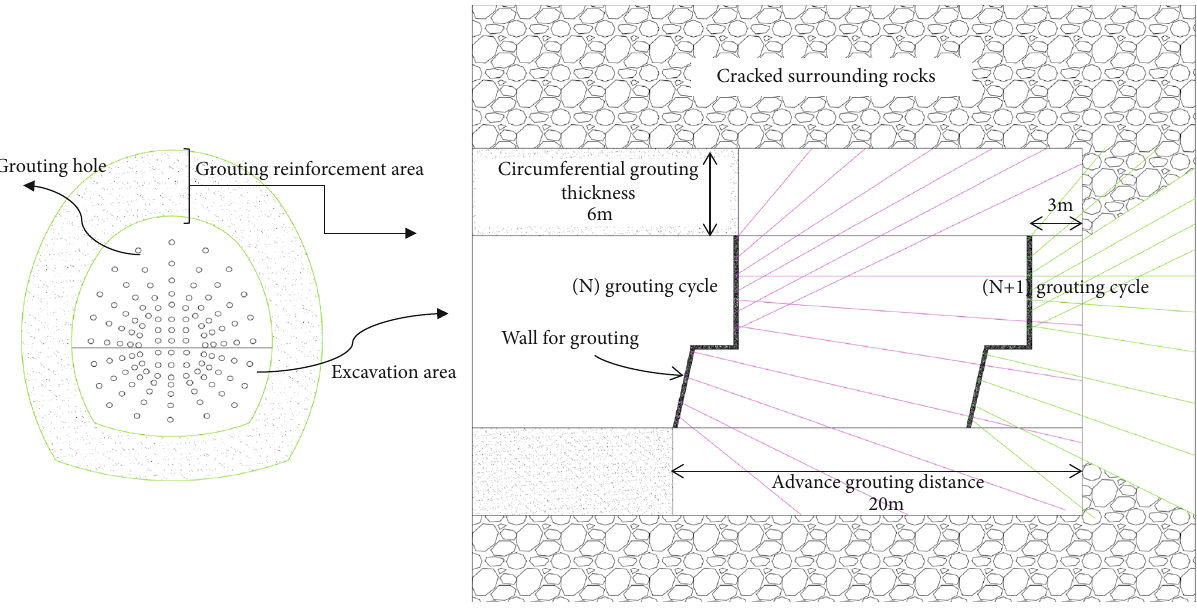
Figure 9: Design of curtain